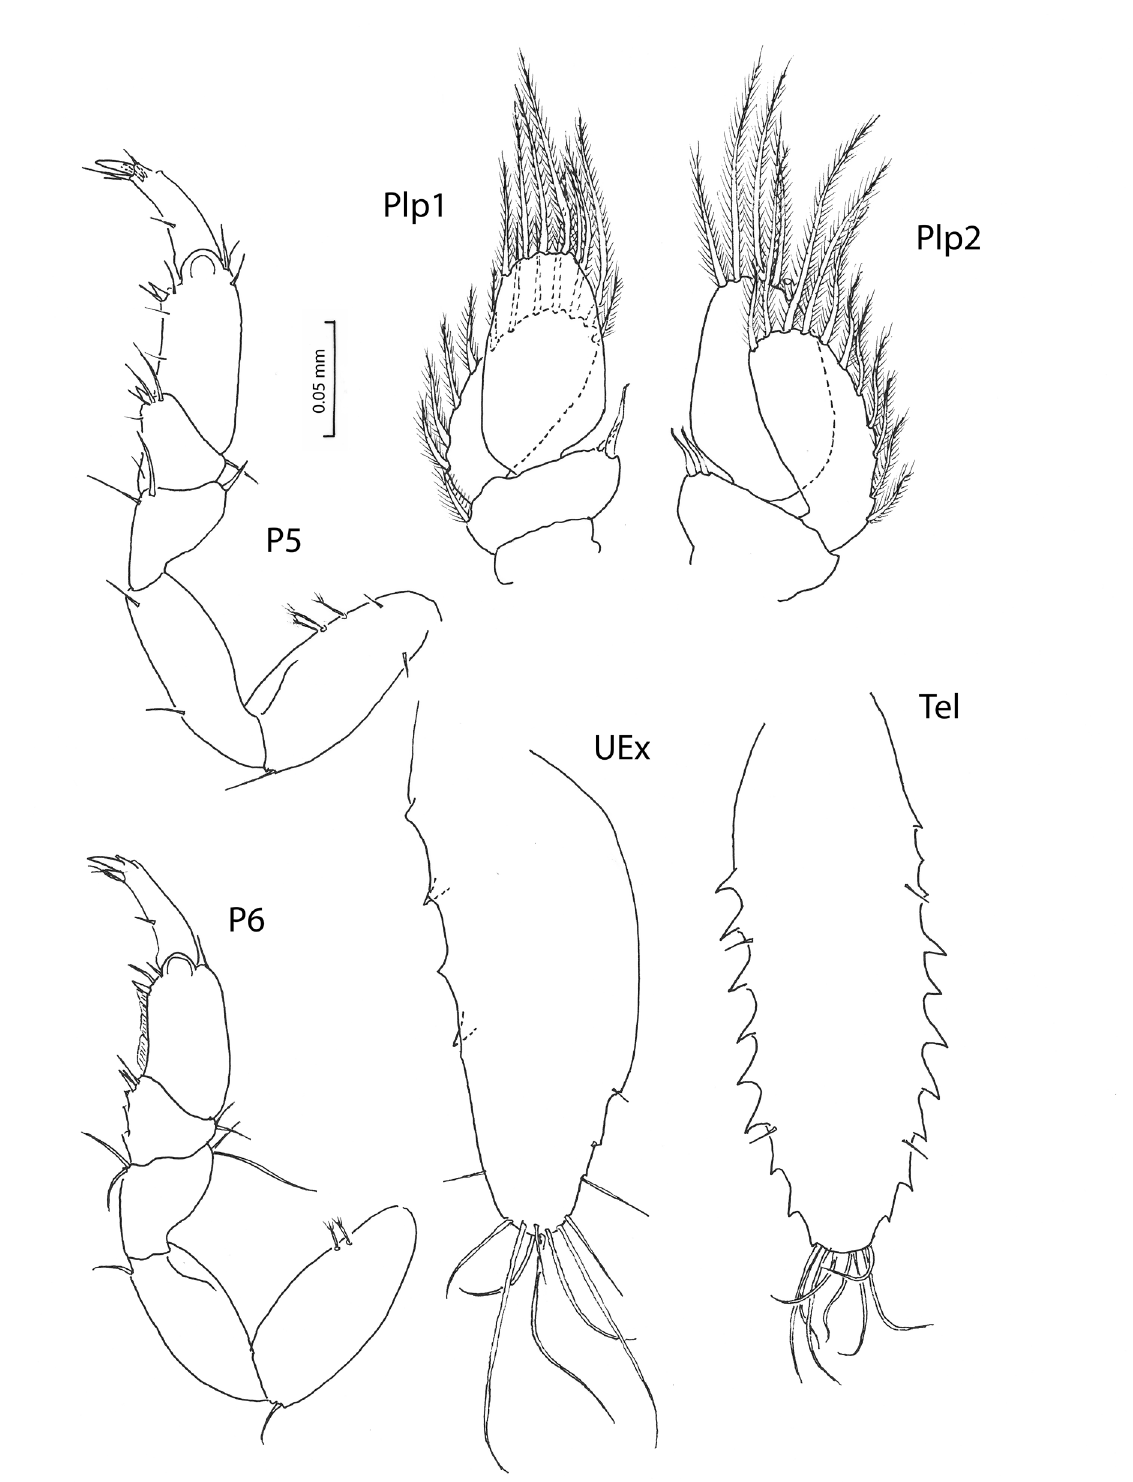
Fig. 12. Kupellonura macaroni sp. nov., holotype, immature adult (MZB Iso 102). Abbreviations: P5– P6 = pereopods 5–6; Plp1–2 = pleopods 1–2, UEx = exopod of uropod; Tel =